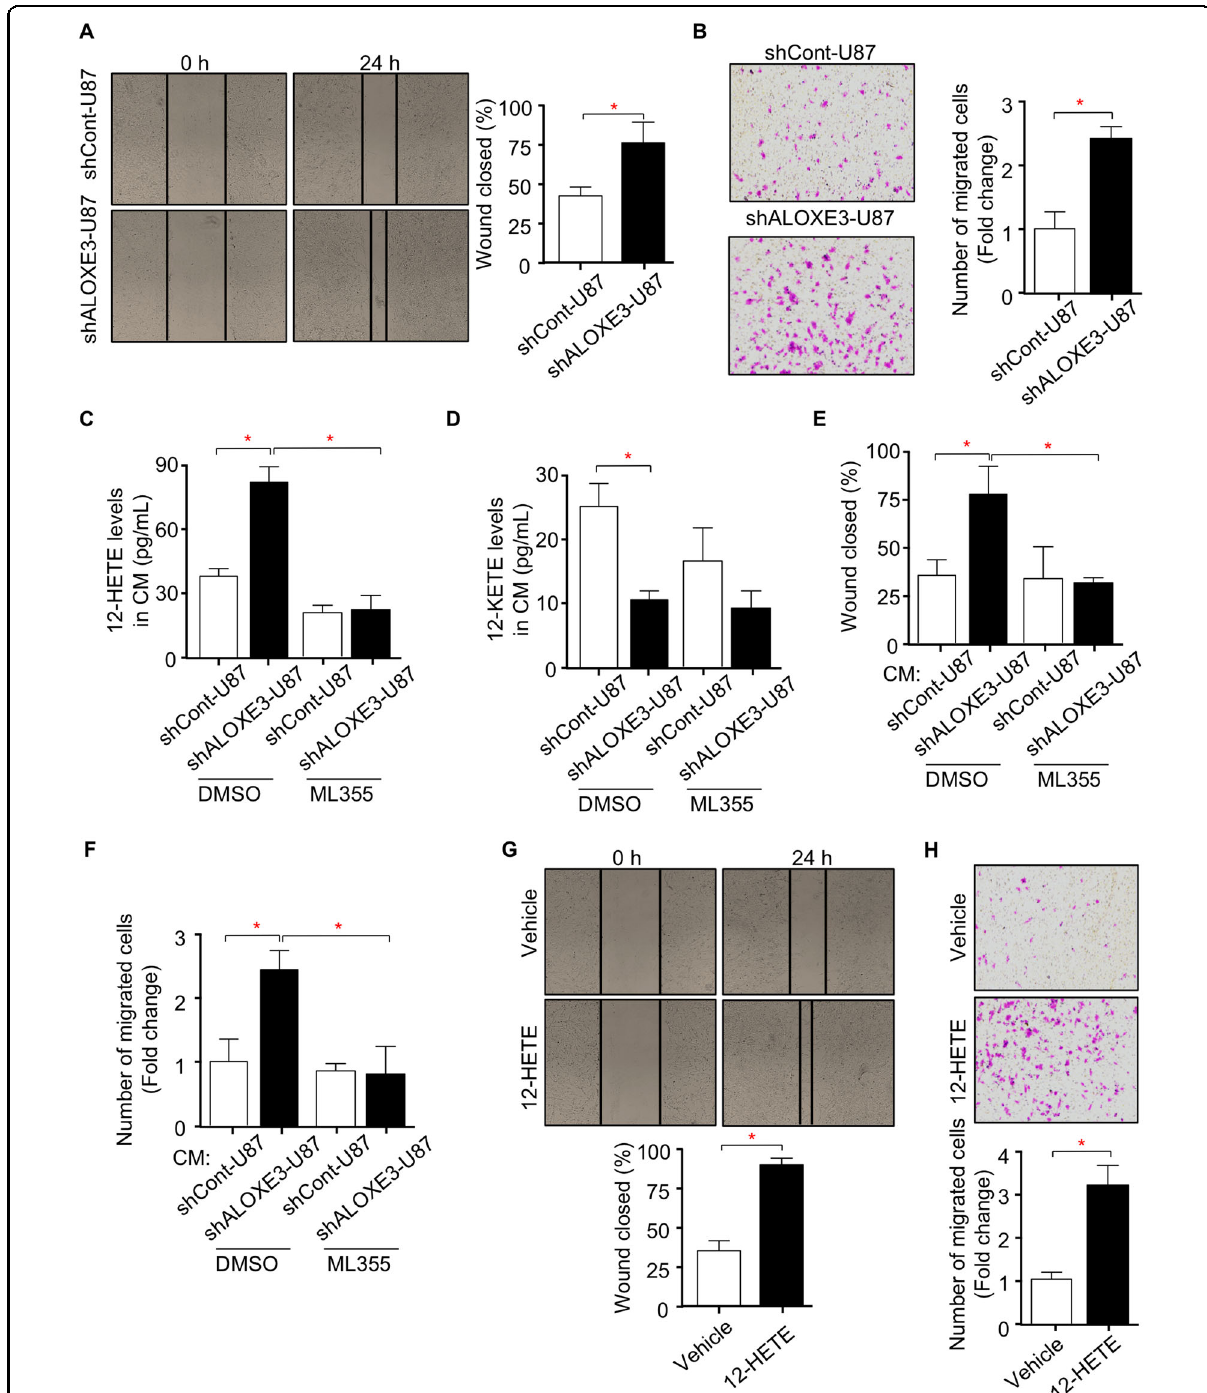
Fig. 6 Knockdown of ALOXE3 promotes migration of GBM cells via 12-HETE in an autocrine manner. A Wound healing assay of shALOXE3- U87 and shCont-U87 cells was determined at 0 and 24 h after the wound was created. The right panel is the percentage of the wound closed at 24 h ( n = 6). B Transwell assay of shALOXE3-U87 and shCont-U87 cells. The right panel is the quanti fi cation of the number of migrated cells ( n = 6). C , D Levels of ( C ) 12-HETE and ( D ) 12-KETE in conditional medium (CM) harvested from shALOXE3-U87 and shCont-U87 cells treated with ML355 or DMSO as control ( n = 6). E , F U87 cells were incubated with CM harvested from shALOXE3-U87 and shCont-U87 cells treated with ML355 or DMSO as vehicle control, and followed with ( E ) wound healing assay and ( F ) transwell assay ( n = 6). G , H U87 cells were treated with 12-HETE or Vehicle control, and followed with ( G ) wound healing assay and ( H ) transwell assay ( n = 6). All data are represented as the mean ± s.e.m. * p < 0.05 (Student ’ s